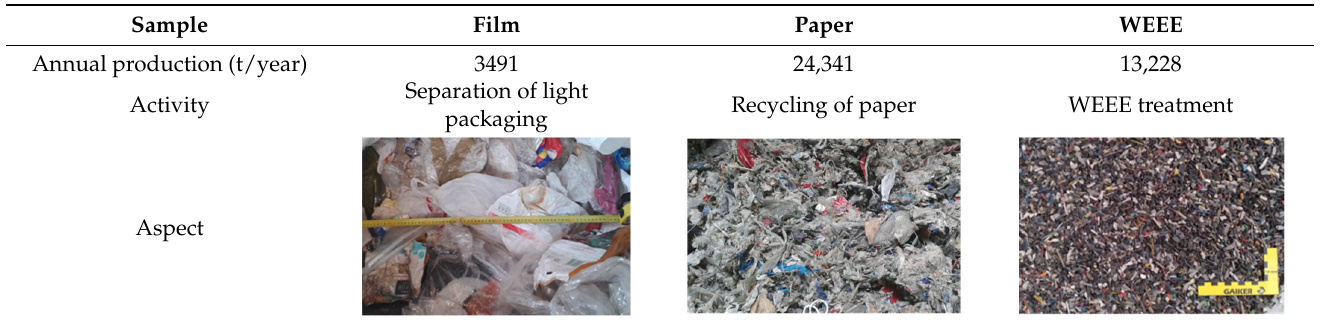
Table 1. Annual production, industrial activity and aspect of the three samples used.